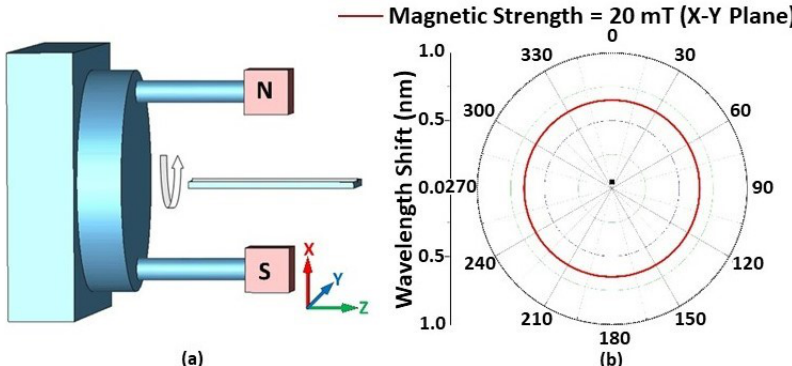
Figure 6. ( a ) The experimental setup used for measuring the angular magnetic field dependence in the X – Y plane, and ( b ) wavelength shift form λ 0 when the rotation angle changes from 0° to 360° in the X–Y plane.